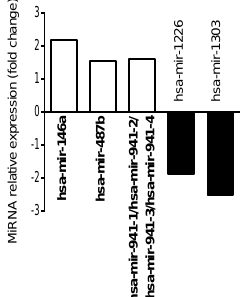
Figure 2. Dysregulated miRNAs in uninfected M cells compared to uninfected Caco-2-cl1 cells. A total of 10 7 LF82 bacteria were added into the apical compartment of M cells or the Caco-2-cl1 monolayers. At 4 h post-infection, the monolayers were collected, washed with cold PBS, and total RNA was extracted and used for miRNA array analysis. The graph shows the relative expression of the miRNAs that were dysregulated in uninfected M cells versus uninfected Caco-2-cl1 cells, presented as fold change (normalized to expression levels of miRNAs in uninfected Caco-2-cl1 cells, defined as 1). 3.3. AIEC Infection Induces Dysregulation of miRNAs in IECs and M Cells